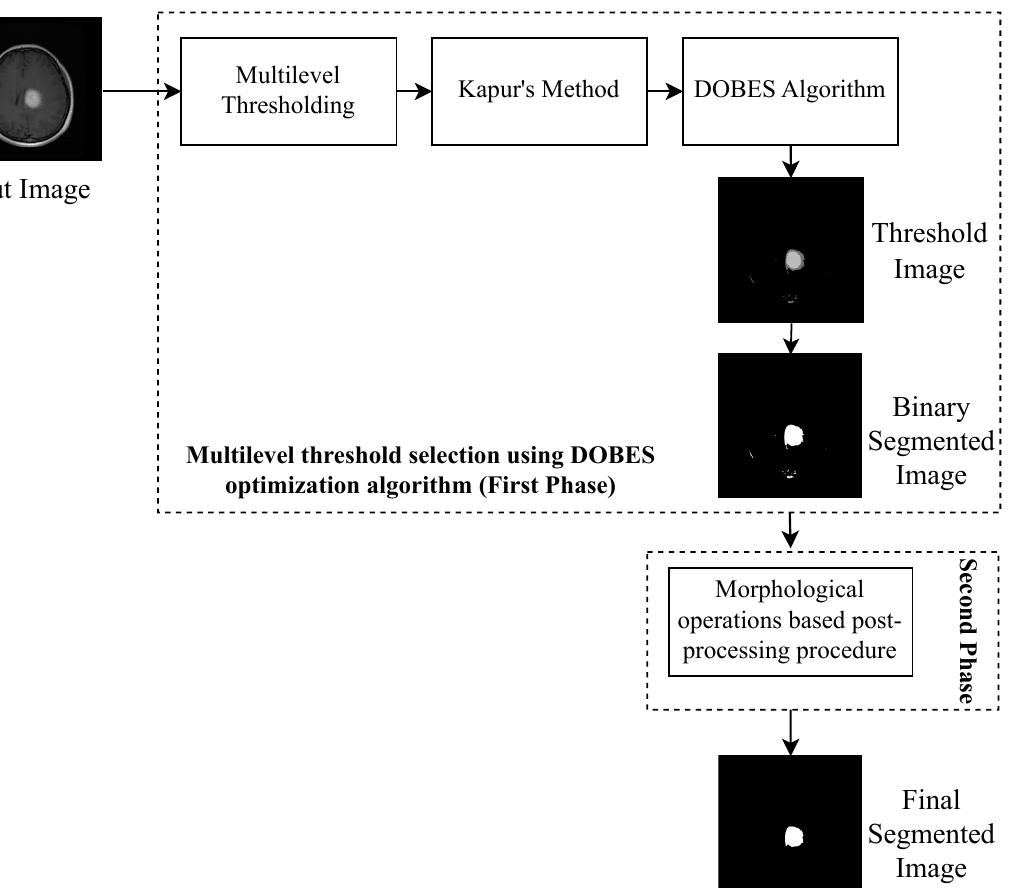
Figure 4. Image processing layout of proposed hybrid multilevel thresholding image segmentation